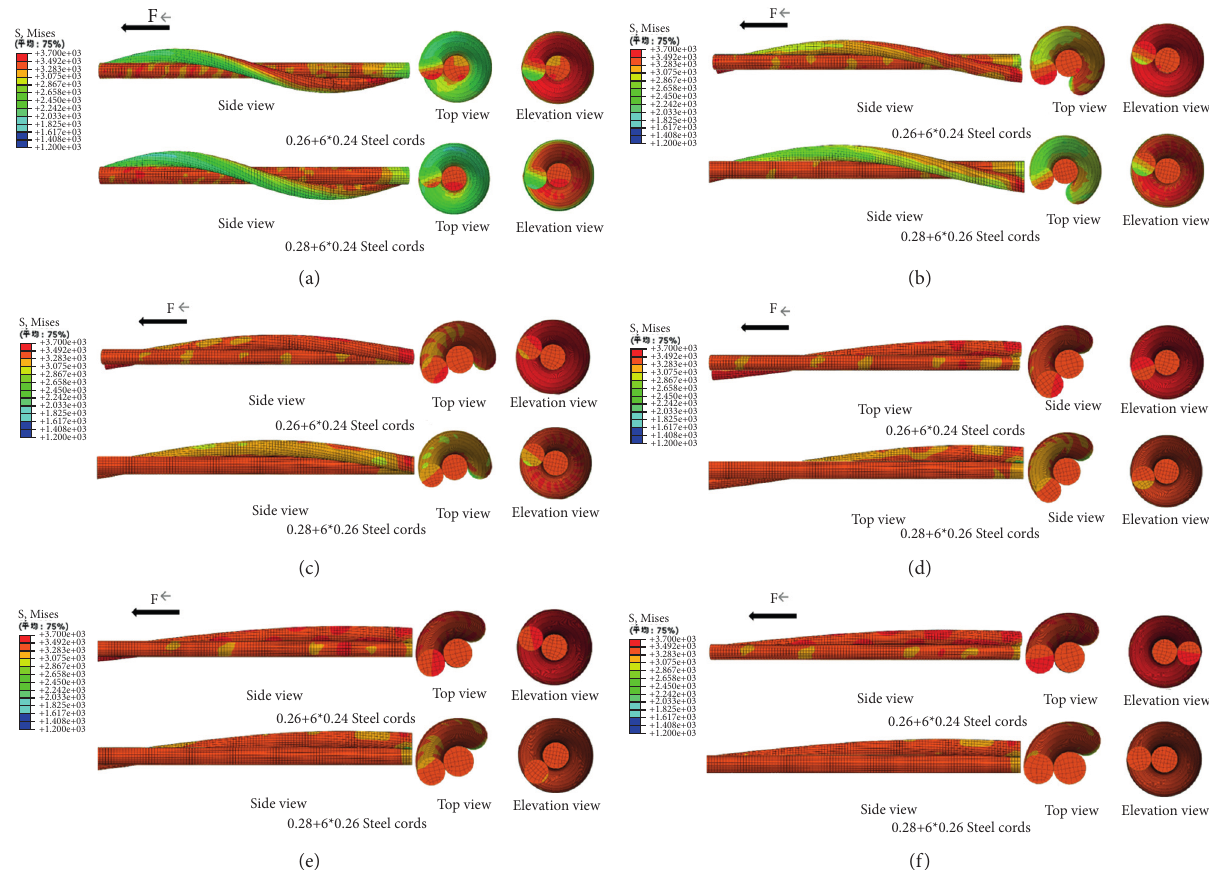
Figure 5: Different lay length steel cords missing the stress cloud map at 0.4mm deformation. (a) P � 5mm; (b) P � 7mm; (c) P � 9mm;